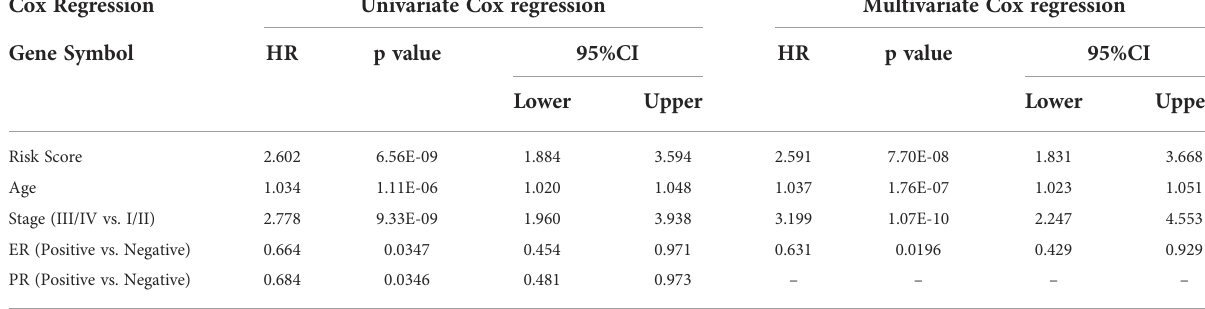
TABLE 2 Cox Regression analysis for Clinical variables and Signature.